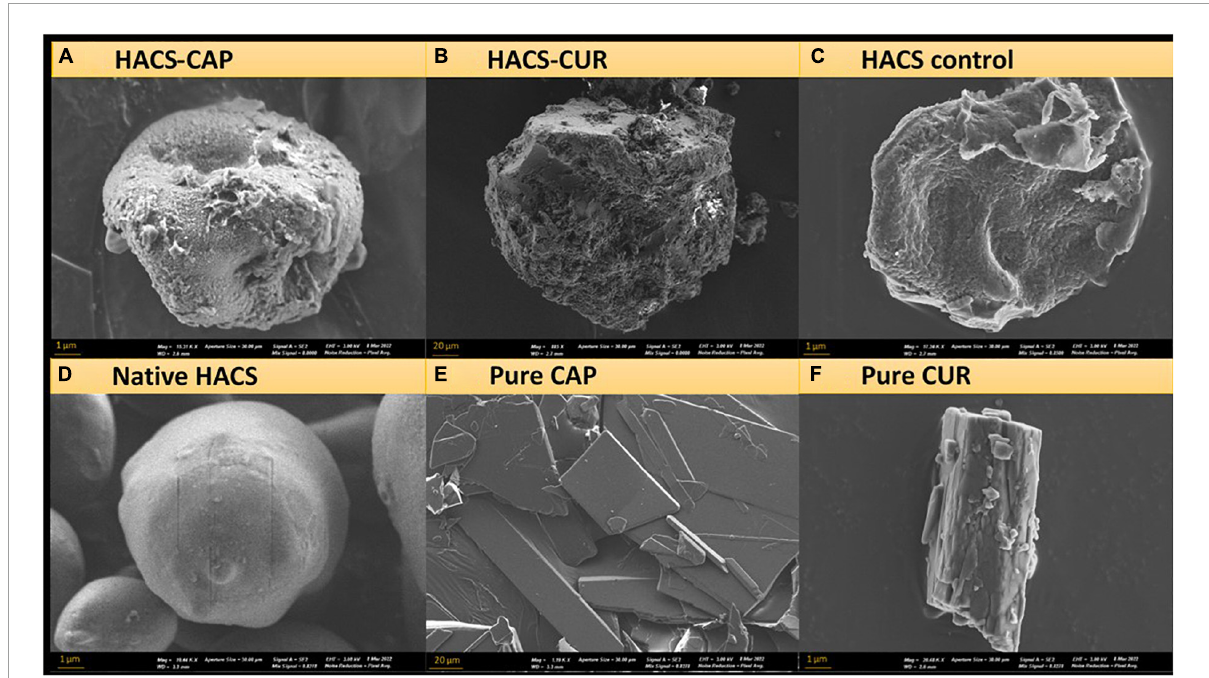
FIGURE3 SEM images of (A) HACS-CAP, (B) HACS-CUR, (C) HACS control, (D) native HACS, (E) pure CAP, and (F) pure